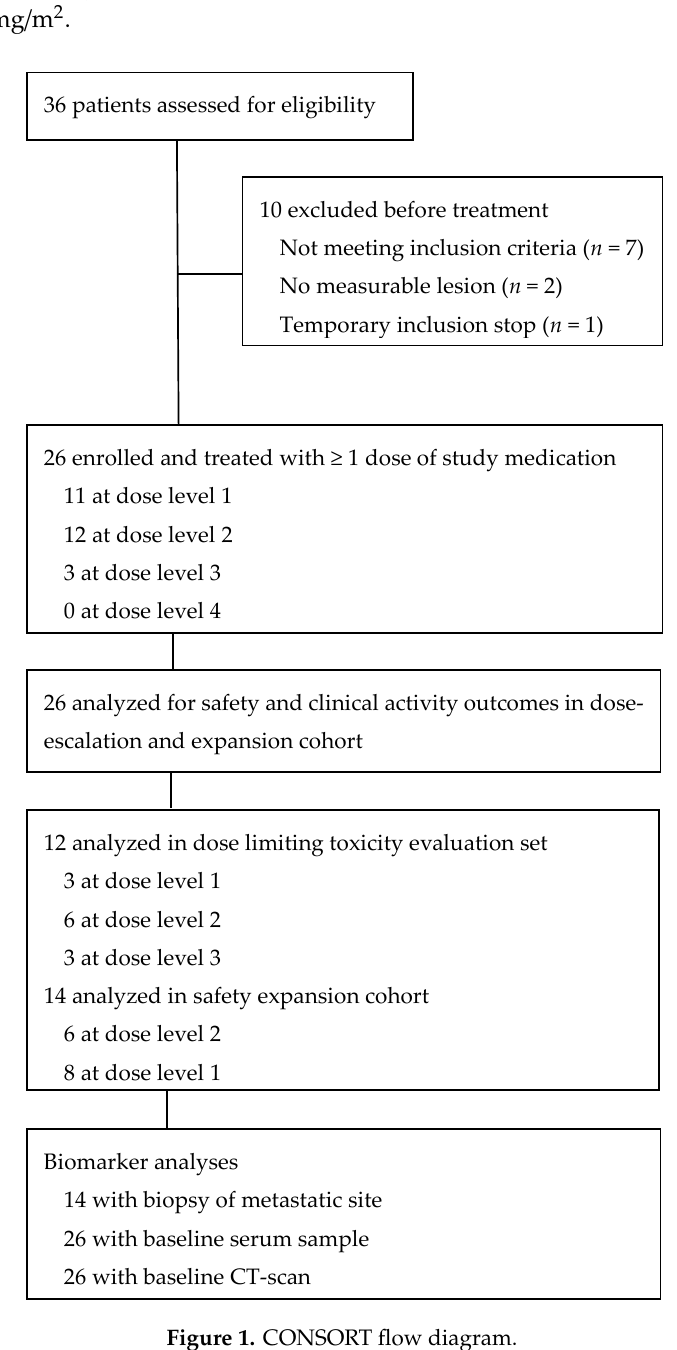
Figure 1. CONSORT flow diagram.